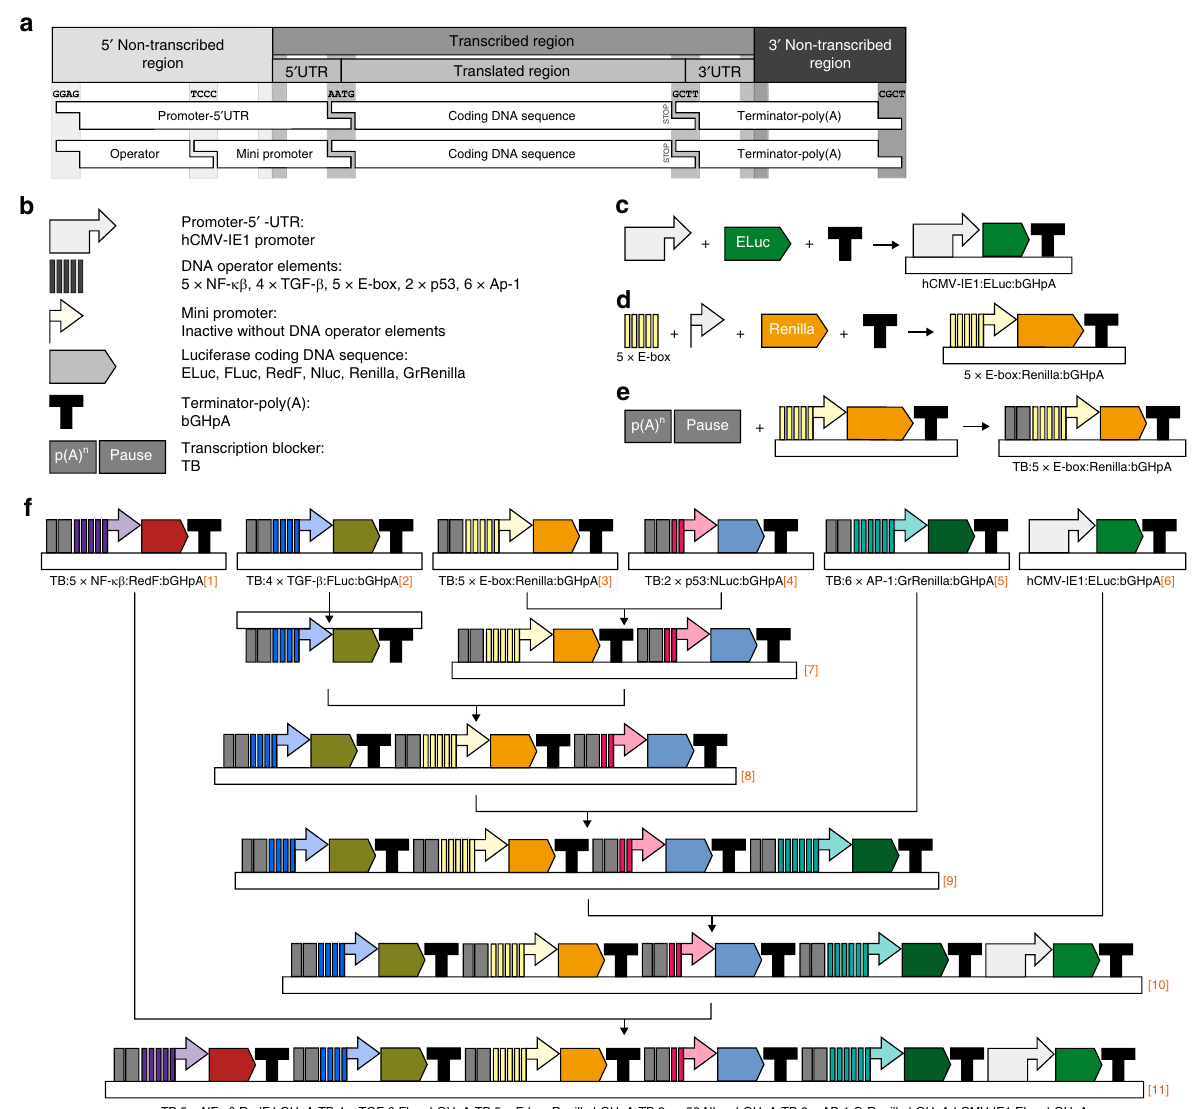
Coding DNA sequence